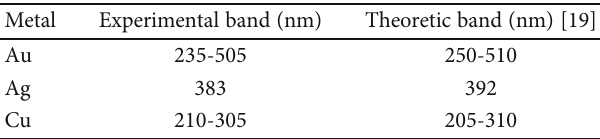
Table 2: UV-Vis spectrum of the Au, Ag, and Cu solvated in